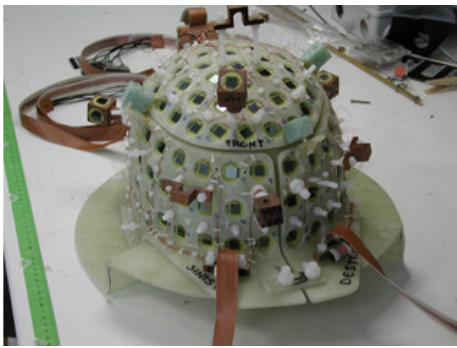
Figure 3. Helmet-shaped array consisting of 163 fully-integrated SQUID magnetometers. The three reference triplets (consisting of 9 SQUIDs) are visible.